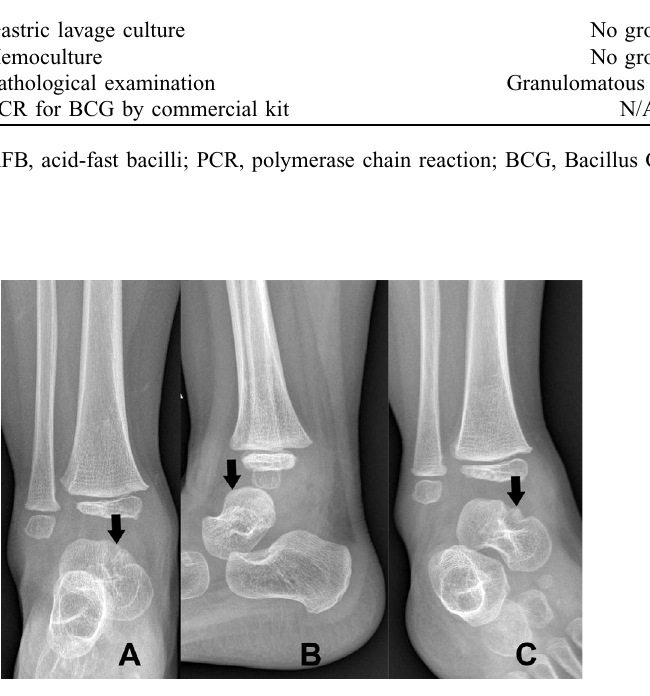
Figure 3. Radiographs of patient 1 at 12-month follow-up are demonstrated. The arrows represent an osteolytic lesion at the talus.